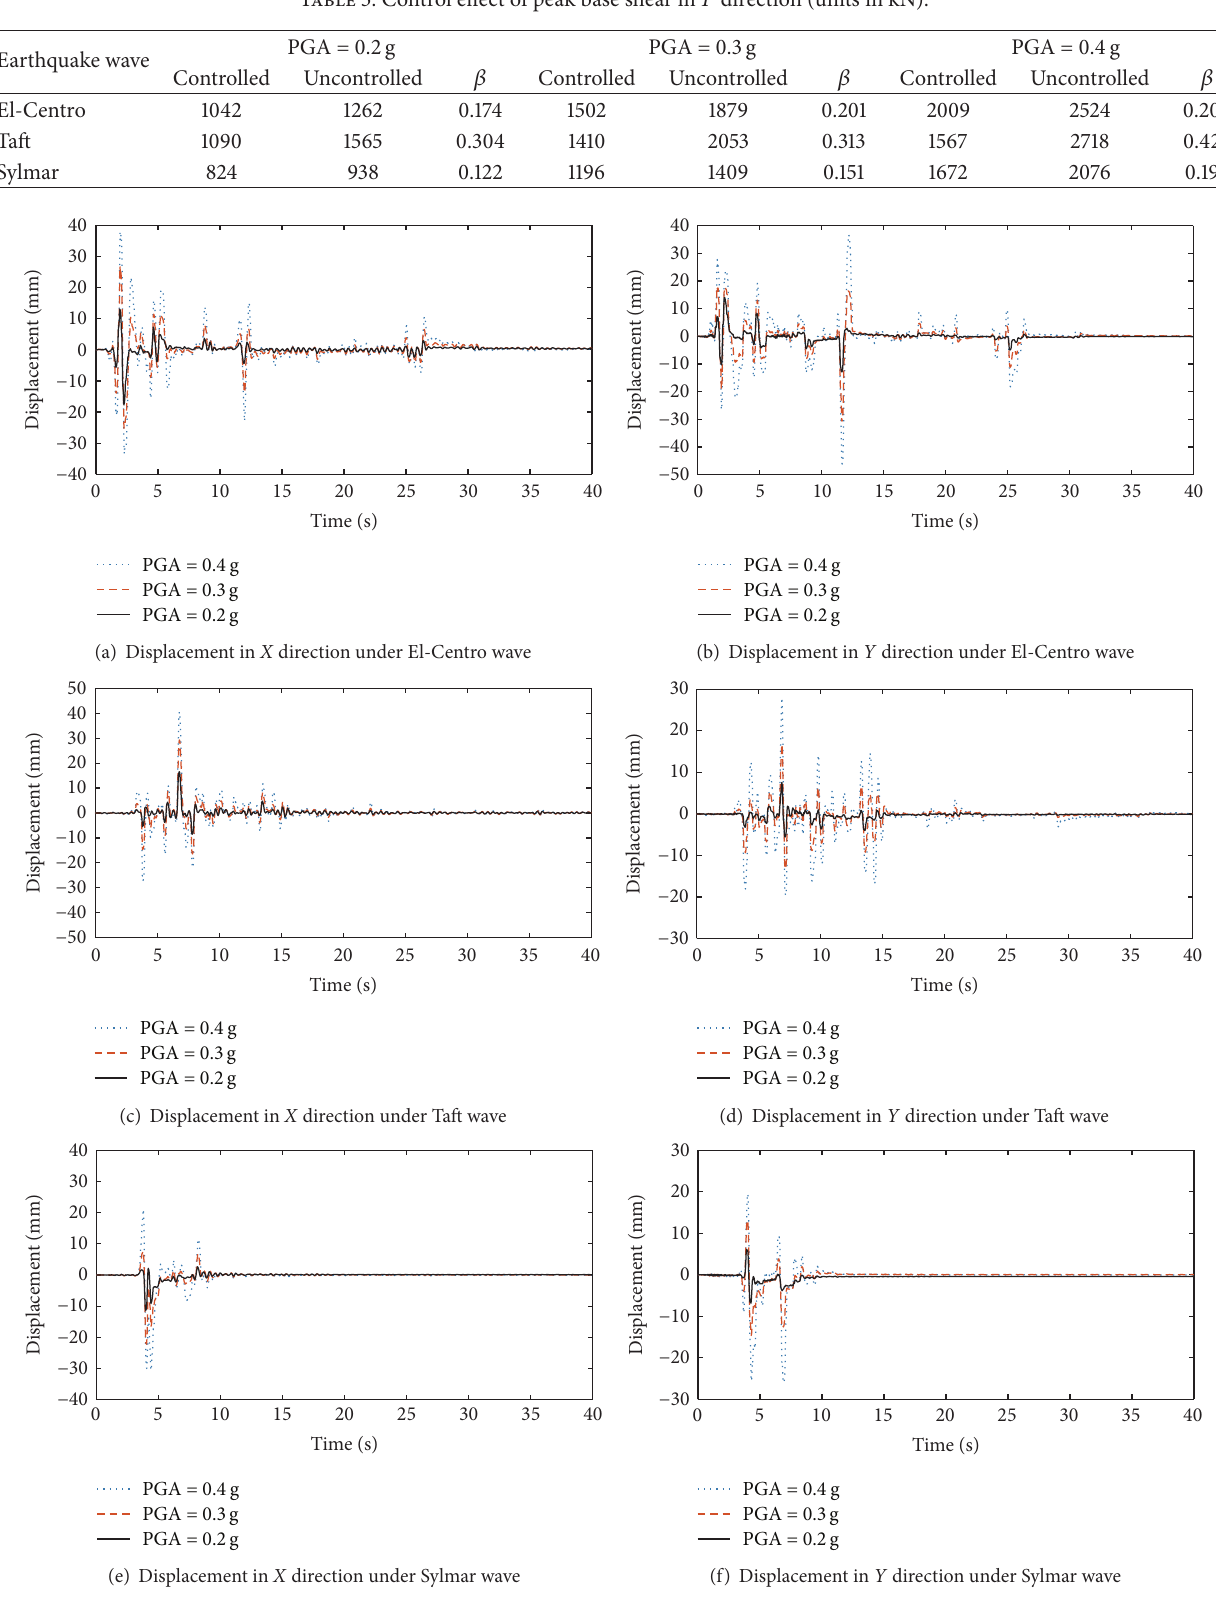
Figure 12: Time histories of isolation system displacement subjected to various seismic